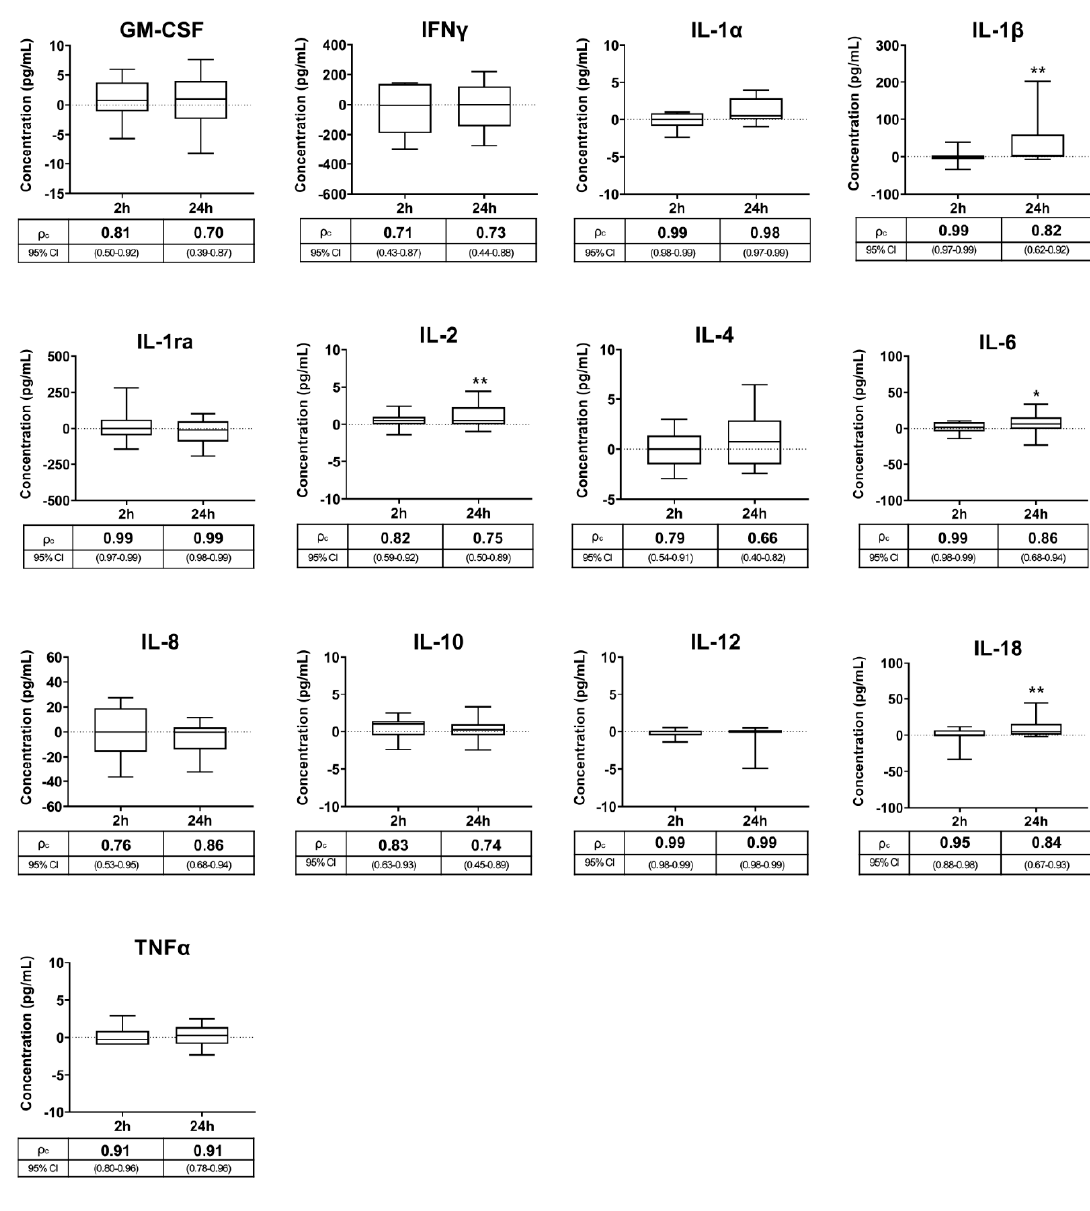
Figure 1. Box-and-whisker plot (horizontal line: median; box: 25 / 75 percentile; whisker: 10 / 90 percentile) showing the di ff erences in cytokine concentrations measured in pig seminal plasma samples (SP) harvested 2 h and 24 h after ejaculate collection with respect to those harvested immediately after ejaculation (baseline samples, point 0 on Y axis). Below the X-axis is the concordance correlation coe ffi cient ( ρ c) and 95% confidence interval (CI) showing agreement between the cytokine concentrations of the baseline and the experimental SP samples. Cytokines: Granulocyte macrophage colony-stimulating factor (GM-CSF), interferon-gamma (IFN γ ), interleukin (IL)-1 α , IL-1 β , IL-1ra, IL-2, IL-4, IL-6, IL-8, IL-10, IL-12, IL-18 and tumor necrosis factor- α (TNF α ). Asterisks indicate statistical di ff erences with baseline data. ** p < 0.01; * p < 0.05.